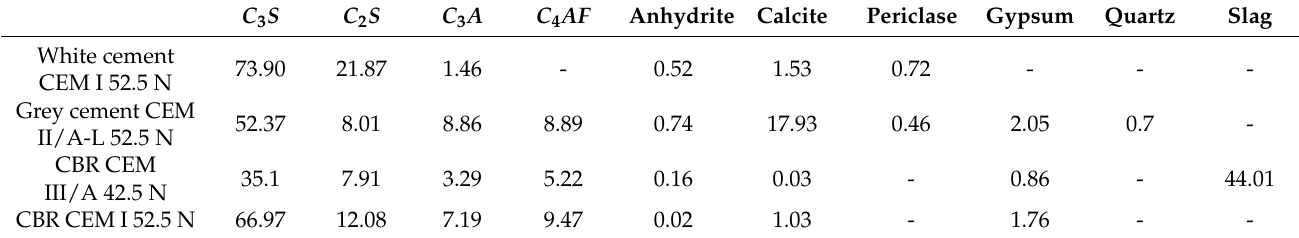
Table 2. Mineralogical composition of cement determined by the XRD-Rietveld